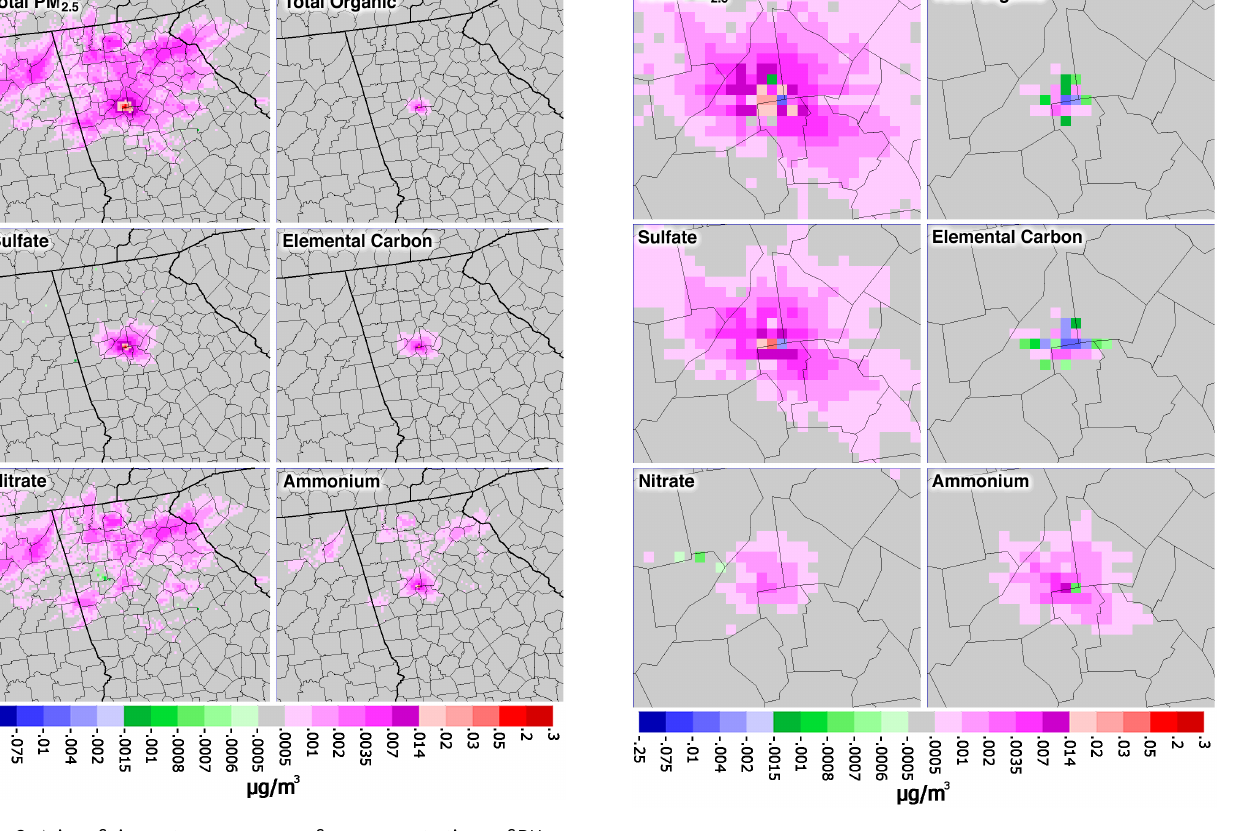
Fig. 4. Effects of plume-in-grid process on average surface concen- trations of PM 2 . 5 and five component species in June and July 2002 (i.e., base case TC1 minus no-PinG case TC3). Each panel shows a 92km by 112km area centered on the